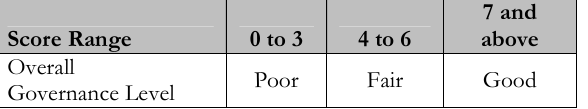
Table 3. Overall Governance Level